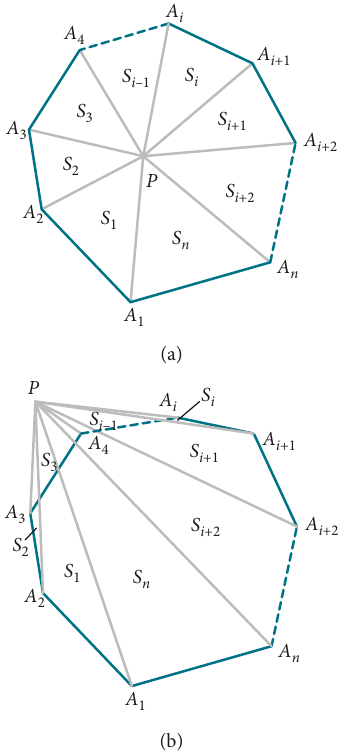
Figure 5: Convex polygon. (a) Point P on the polygon; (b) point P outside the polygon.